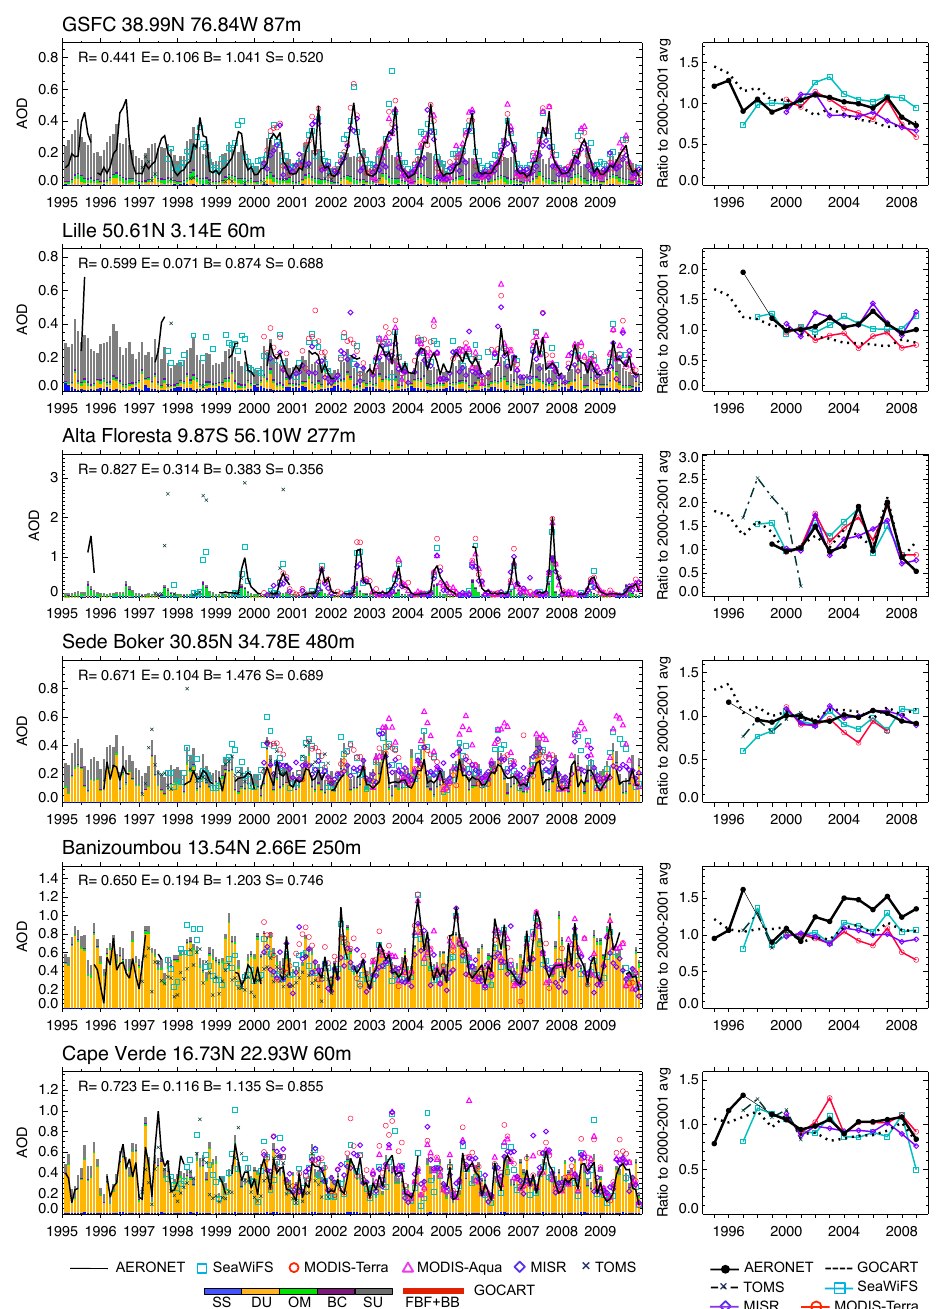
Fig. 7. Left column: monthly AOD from 1995 to 2009 at five AERONET continental land sites, GSFC in eastern USA, Lille in France, Alta Floresta in the Amazon, Sede Boker in Israel, and Banizoumbou in the Sahel. AOD at the Cape Verde site off the west coast of North Africa is also shown (last row). Statistical measures of comparisons between observations and GOCART are shown on each panel: R = correlation coefficient, E = root mean square error, B = mean bias (model/observation), and S = skill score (Taylor, 2001). Right column: ratio of annual mean AOD to the 2000–2001 average at corresponding sites, showing the interannual variability/trend over the 15-year period with the AERONET data in black solid, satellite observations in colored solid, and model in dotted black lines. Thin solid black line in the right column connects the points with missing year(s) in between for visual